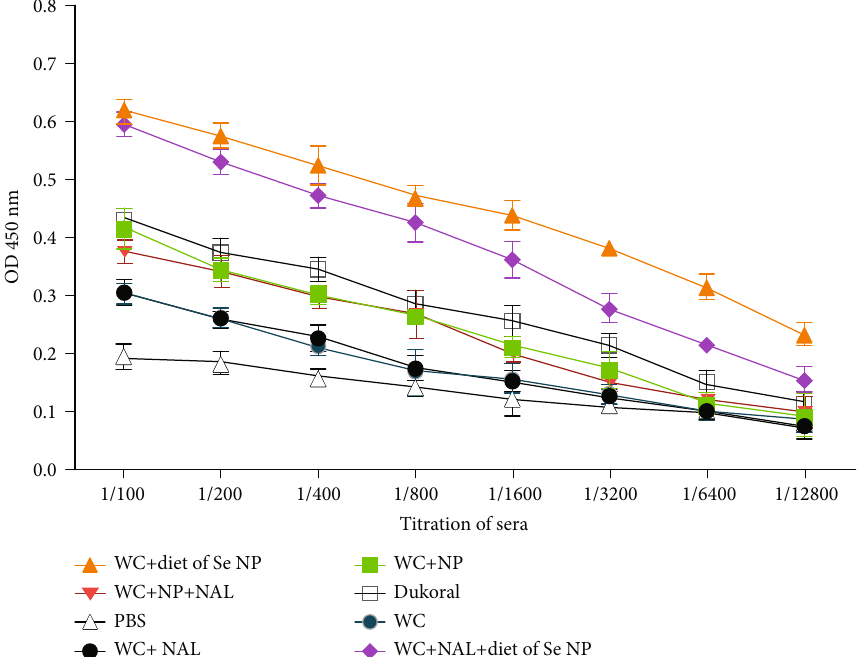
Figure 6: Titration of IgG antibody in sera in di ff erent immunized mouse groups on day